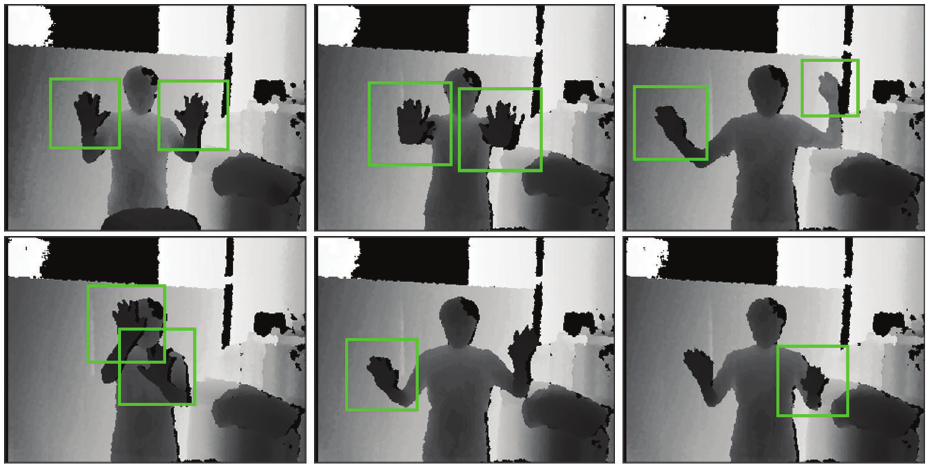
Figure 14: Detection